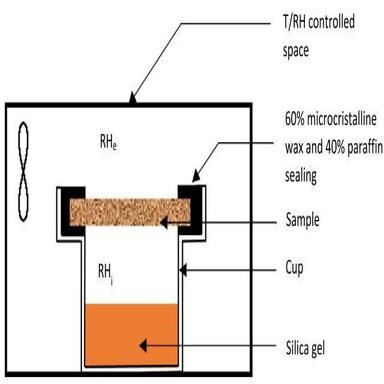
Principle diagram of the cup test method.